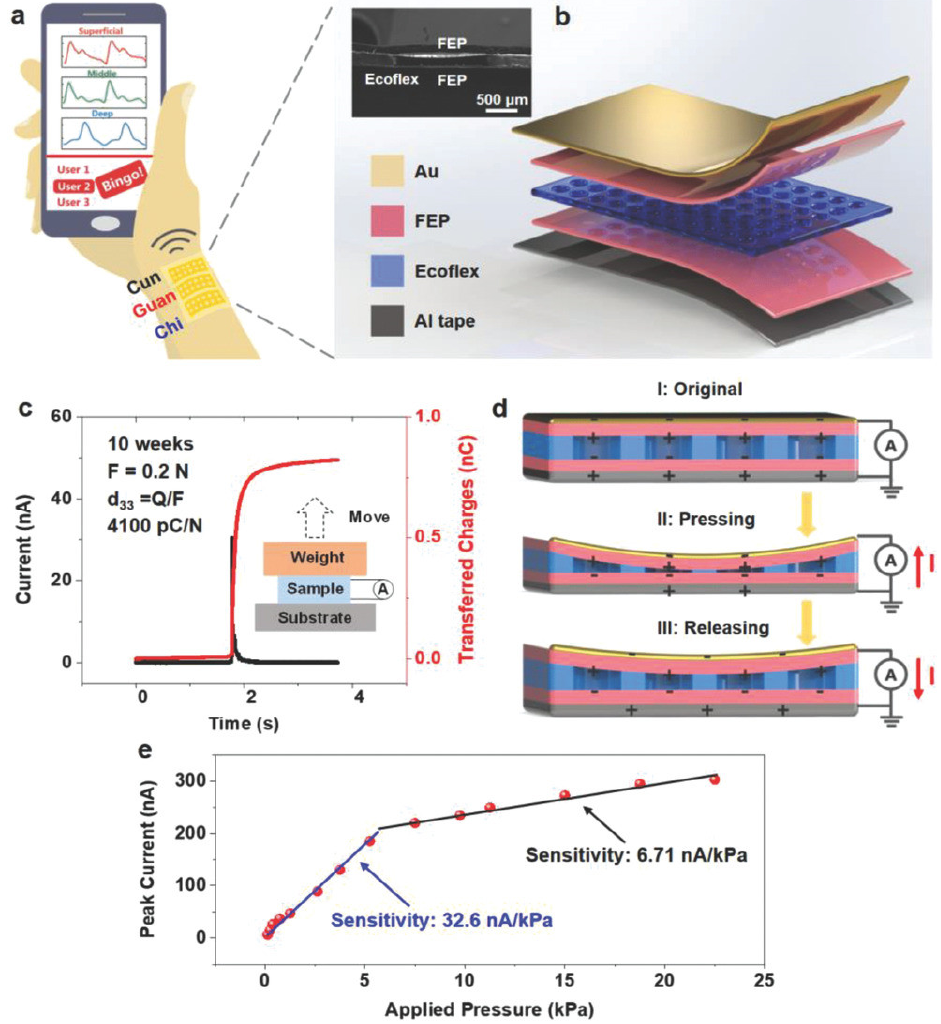
Figure 22. Representation of the sandwich-structure piezoelectret to supply a pulse-sensing system fabricated by Chu et al. [112]. ( a ) Schematic representation of the pulse-sensing system for monitoring pulse signals at the Cun, Guan, and Chi regions of the wrist. These signals could be transmitted to a smart phone. ( b ) Structural configuration of the pulse sensor integrated by the FEP/Ecoflex/FEP piezoelectret layer. ( c ) Experimental results of the equivalent piezoelectric coefficient (d 33 ) of the piezoelectret structure of the pulse sensor. ( d ) Working mechanism of the pulse sensor into its stages of pressing (I-II) and releasing (III-I), which induces the flow of electrical currents. ( e ) Experimental results of the sensitivity of peak short-circuit currents generated by a pulse sensor when an external pressure range is applied to it with a frequency of 1.5 Hz. Reprinted with permission from [112].